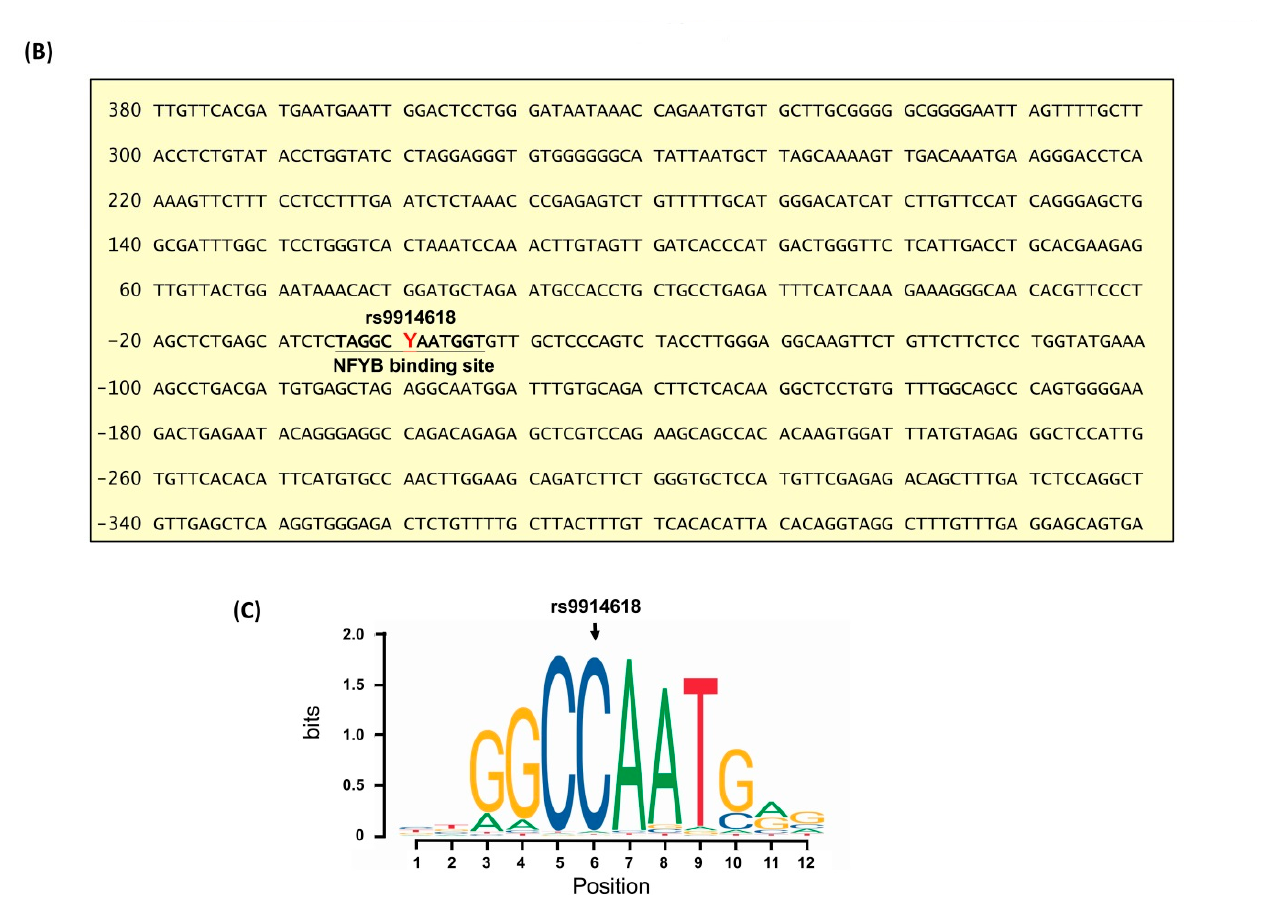
Figure 2. Intron structure of LINC00673 (NR_137201.2) and the features of rs9914618. ( A ) The intron spanning the chromosome position chr17:70,577,054 to 70,577,355 (reference genome GRCh37.p13) is shown, and the SNPs of LNC00673 are indicated by the black bars. rs9914628 is centered and marked with reference SNP ID number. The H3K4Me1, H3K4Me3, and H3K27Ac tracks exhibit the enrichment of the mono-methylation of lysine 4, trimethylation of lysine 4, and acetylation of lysine 27 of the H3 histone protein, as determined in ENCODE project. DNase clusters track indicates DNase hypersensitivity regions. Chromatin State Segmentation tracks display chromatin state segmentations by integrating ChIPseq data with a hidden Markov model for H1-hESC embryonic stem cells. The chromatin state region predicted for transcribed regions is highlighted in green. ( B ) Sequence of the intron 1 region. The putative NFYB binding motif (MA0502.2) is shown in bold fonts. Y indicates the position of rs9914628 and denotes C or T. ( C ) Motif logo of NYFB consensus sequences.